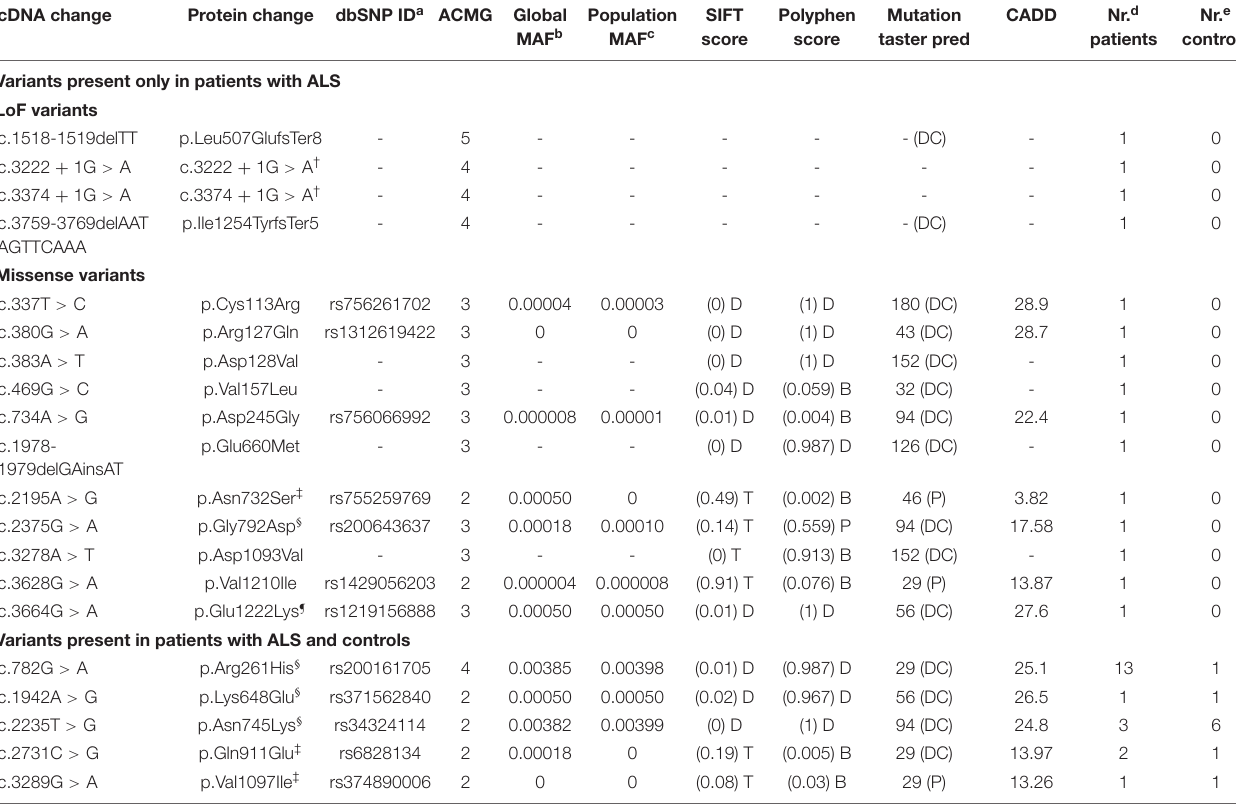
TABLE 1 | All the NEK1 variants found in our NGS